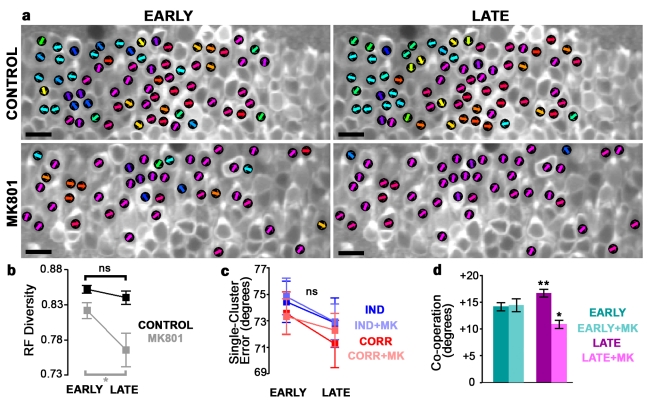
NMDAR-dependent coordination between clusters supports network encoding improvement.(a) Preferred directions of example control (top) and MK801-treated (bottom) tadpoles during early (left) and late (right) epochs. Scale bar = 20 µm. (b) Receptive field diversity across the tectum during early and late epochs, in untreated (black) and MK801-treated (gray) tadpoles. Diversity decreased with training in MK-801–treated tadpoles (paired t-test, p<0.05). (c) Mean decoding error of independent (blue) and correlation-based (red) decoding of single clusters during early and late epochs, in untreated and MK801-treated (lighter shades) tadpoles. (d) Mean decoding cooperation (decoding performance of two clusters taken together minus the maximum decoding performance of either taken alone) during early and late epochs, in untreated and MK801-treated tadpoles. Cooperation increased in control tadpoles and decreased in MK-801 treated tadpoles with training (paired t-tests). Number of clusters: untreated, n = 29; MK801, n = 25 clusters per epoch in seven tadpoles. Error bars denote SEM. Control, n = 7 tadpoles (277 neurons); MK801, n = 7 tadpoles (255 neurons). *p<0.05; **p<0.01.